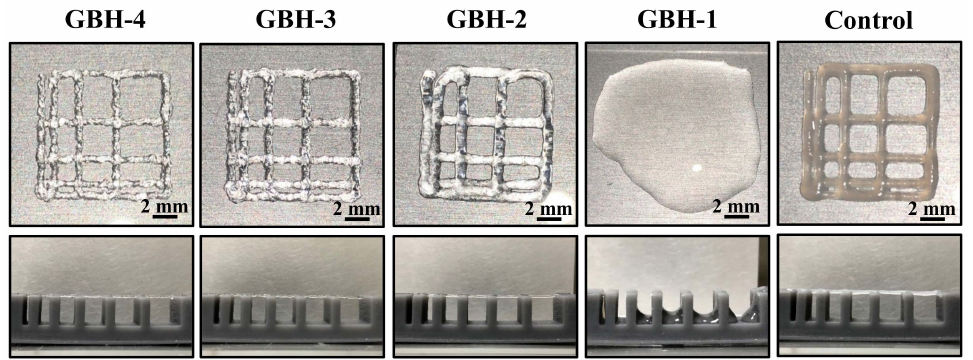
Figure 5. The rheological properties of the investigated hydrogels: ( a ) viscosity and ( b ) shear stress.